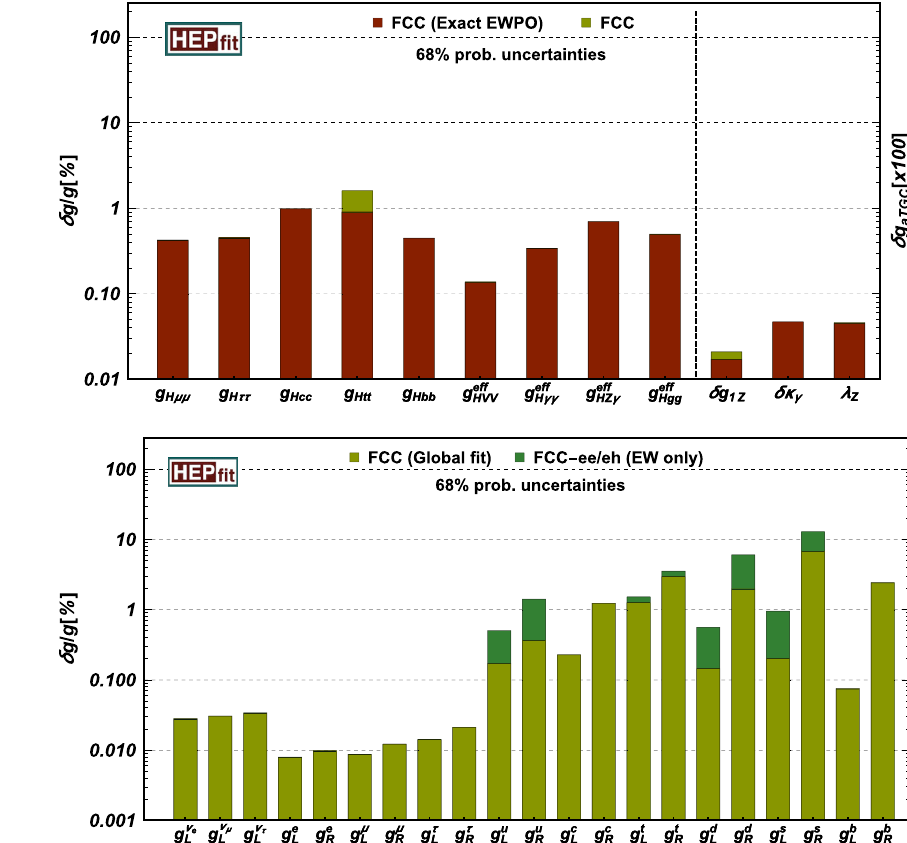
Fig. 8.7 One-sigma precision reach of the combination of FCC-ee/eh/hh on the 12 effective single Higgs couplings and aTGC from the global fit to EW and Higgs observables, compared with the results presented in Sect. 8.4 assuming perfect EW measurements